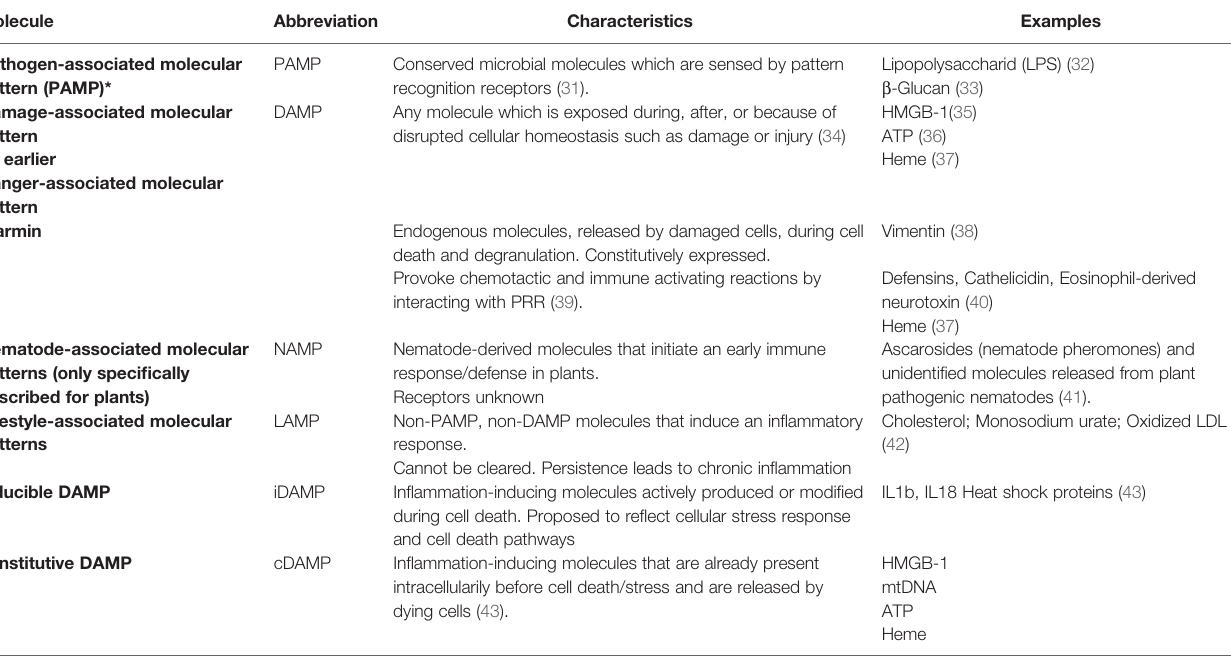
TABLE 1 | De fi nitions of PAMP, DAMP and de fi ned sub entities. Molecule Abbreviation Characteristics